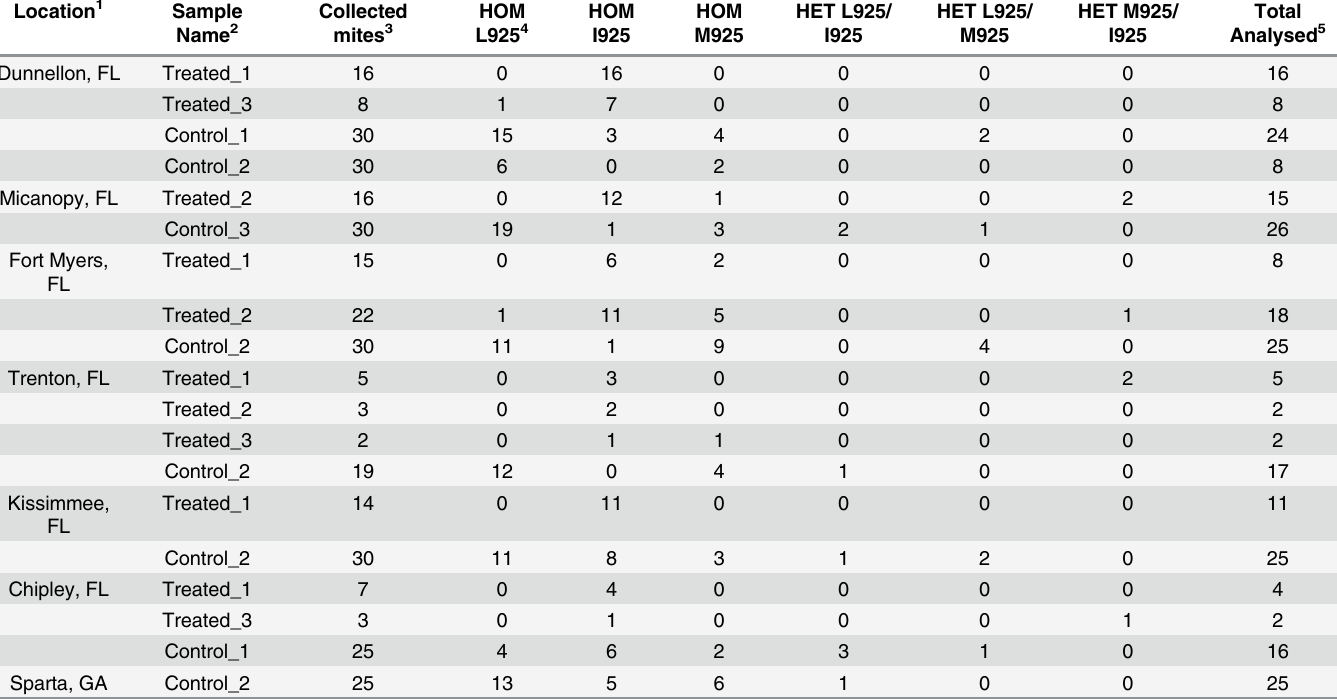
Table 1. Genotyping results for individual V . destructor collected in seven locations in the Southeastern USA using the TaqMan 1 allelic discrimi- nation